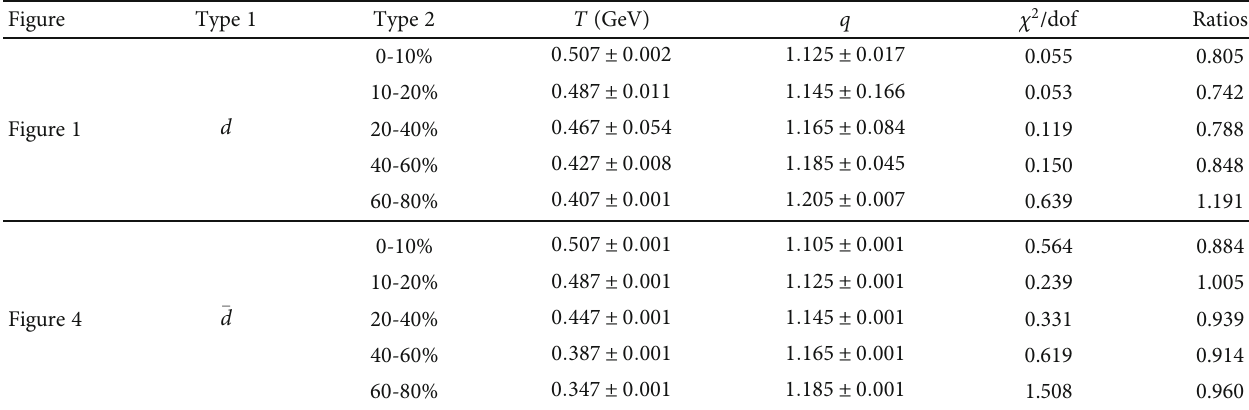
Table 2: Values of T , q , and χ 2 /dof corresponding to the curves in Au+Au collisions at 60%, and 60-80% centralities. The “ Ratios ” is the average ratios of experimental data to